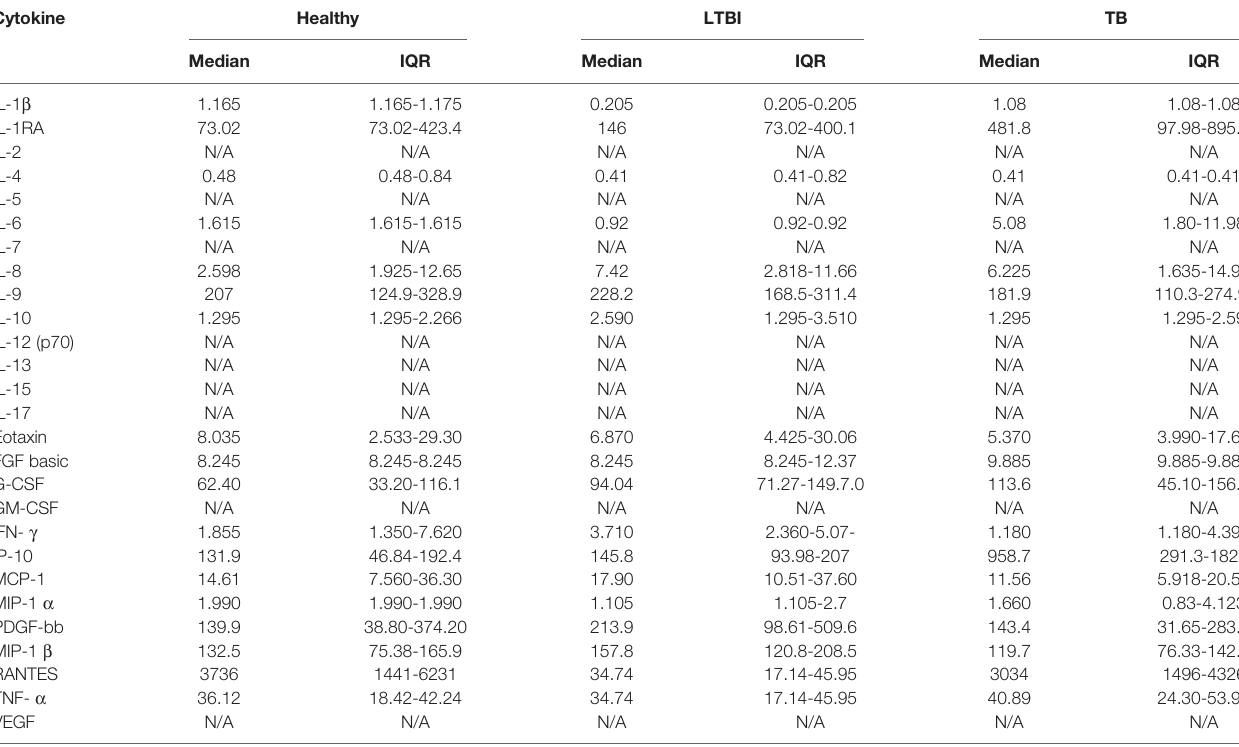
TABLE 3 | Absolute protein abundance of all cytokines assessed in this study. Cytokine Healthy